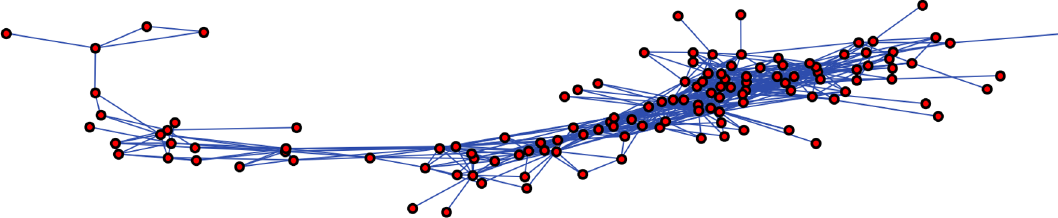
Figure 5. Graph structure for T = 6 and b i = (0 , 0 , 0) , showing the pairwise compatibility of A 0 branes with | b X I | ≤ ( T 3 , T, T, T ) . Each vertex represents an A brane and two vertices are connected 0 by an edge if together they give an admissible constraint matrix and satisfy the (bootstrapped) tadpole bounds. There are 399 vertices (270 are isolated and not shown), 539 edges, 364 3-cliques, 107 4-cliques, 20 5-cliques, 1 6-clique and no k -cliques for k ≥ 7